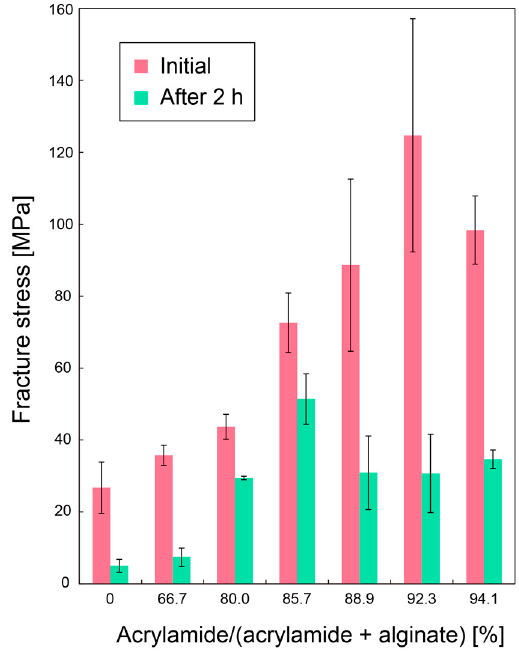
Figure 8. Fracture stress of the microfiber due to elongation as a function of the composition ratio of acrylamide and alginate.